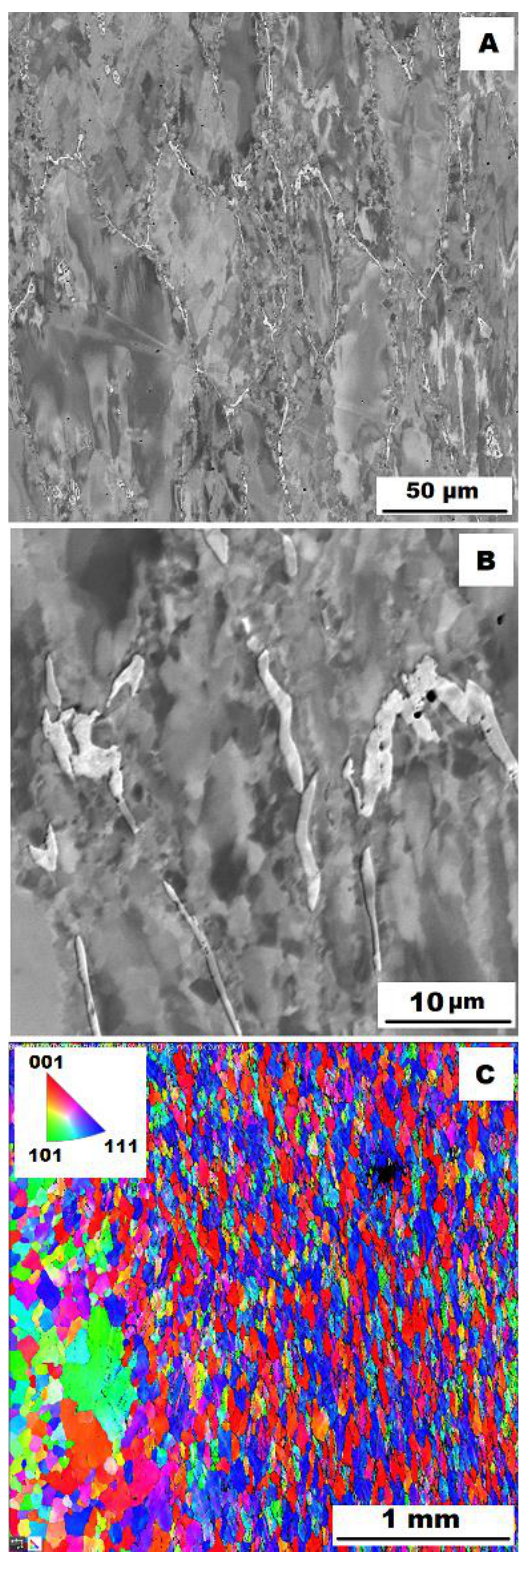
Figure 13. The structure of Fe – 28Al – 5Si – 1B HT 800/100 alloy after compression test at 600°C. ( A ) Overview of the structure-10 kV, BSE. ( B ) Detail of the structure-10 kV, BSE. ( C ) EBSD map of grains-area 3 × 3 mm, step size 2 µm, 20 kV.